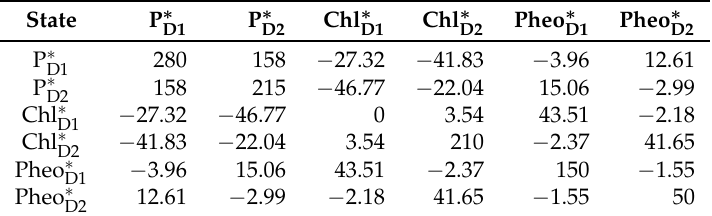
Table A1. FE site energies (diagonal) adapted from Gelzinis et al. [21] and FE–FE couplings (off-diagonal) from Shibata et al. [25]. All numbers are in units of cm − 1 . The site energies are subtracted by 14,800cm − 1 for clarity.